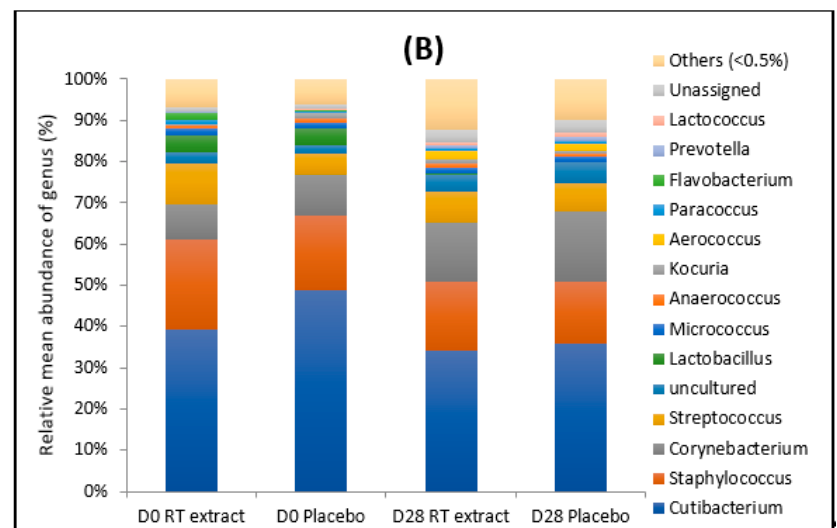
Figure 1. Mean relative phyla ( A ) and genera ( B ) abundances for each group of samples. For the sake of clarity, only phyla with mean relative abundance superior than 0.1% and genera with mean relative abundance superior than 0.5% are represented.